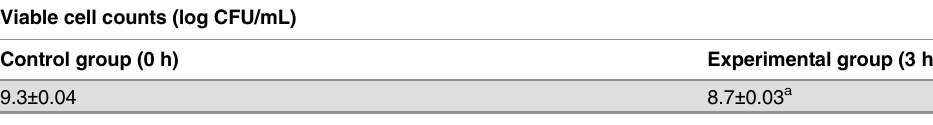
Table 2. Effects of artificial gastric juices on the viability of L . plantarum CCFM8246.